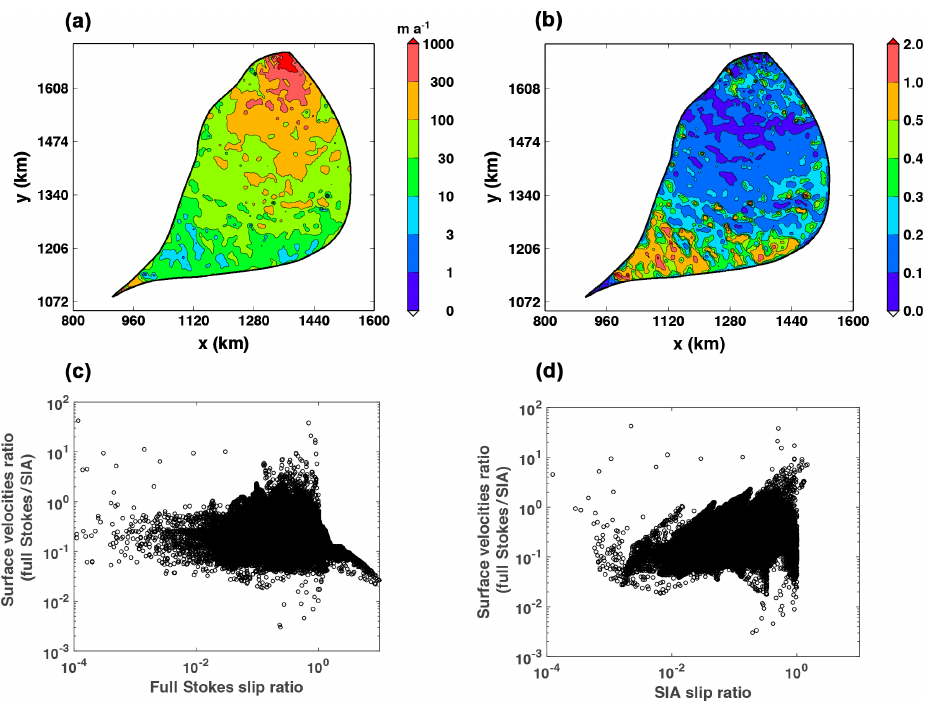
Figure 4. (a) Surface velocities computed using SIA, applying the basal friction coefficient β obtained with the control inverse method (Fig. 3d), (b) surface velocity ratio (FS / SIA), (c) scatter plot of the surface velocity ratio vs. the FS slip ratio and (d) scatter plot of the surface velocity ratio vs. the SIA slip ratio. The slip ratio is the ratio of the basal to the surface velocity for any given